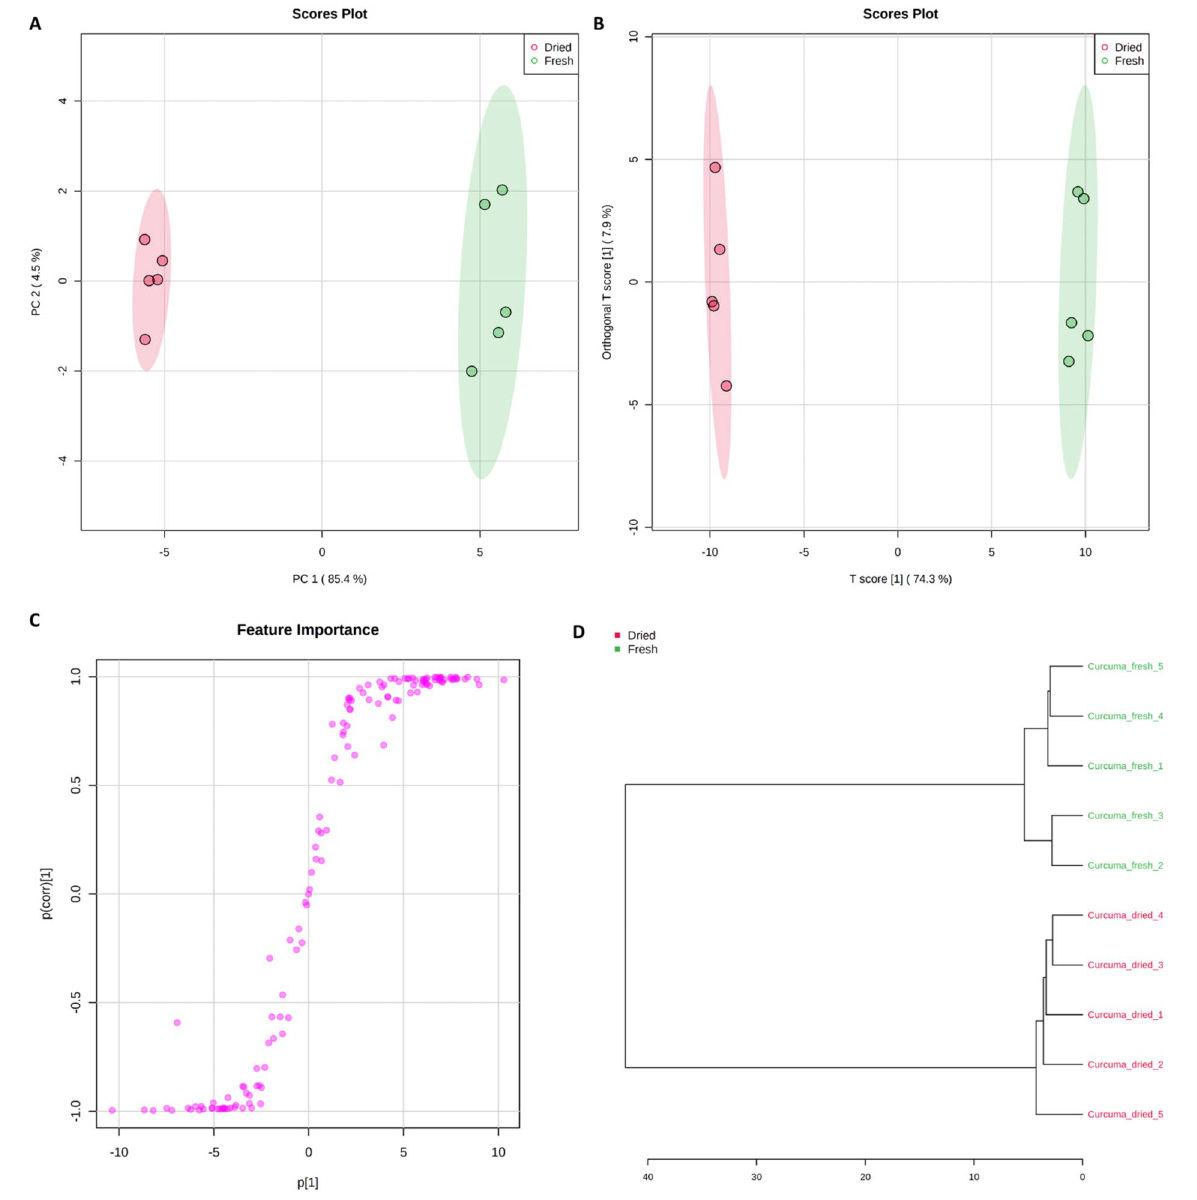
Figure 4. ( A ) Principal Component Analysis (PCA) score plot of fresh and dried turmeric ( Curcuma longa L.) samples (n = 5). A complete separation is shown between both samples mainly on the PC1 (85.4%); ( B ) Orthogonal Projections to Latent Structures Discriminant Analysis (OPLS-DA) score plot which also confirms the PCA results; ( C ) OPLS-DA S-plot from which raffinose, threose, glycolic, fumaric, pyruvic acids, and monomethyl curcumin potentially marked dried samples, while metabolites such as amino acids and sesquiterpenoids were more associated with fresh rhizomes. ( D ) Hierarchical cluster analysis (HCA) of fresh and dried turmeric samples using Ward´s clustering